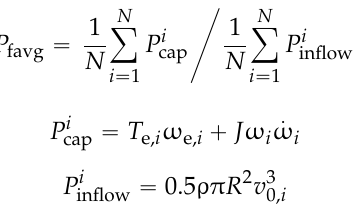
Figure 9. Twist angle distributions of the optimized and the original blades.